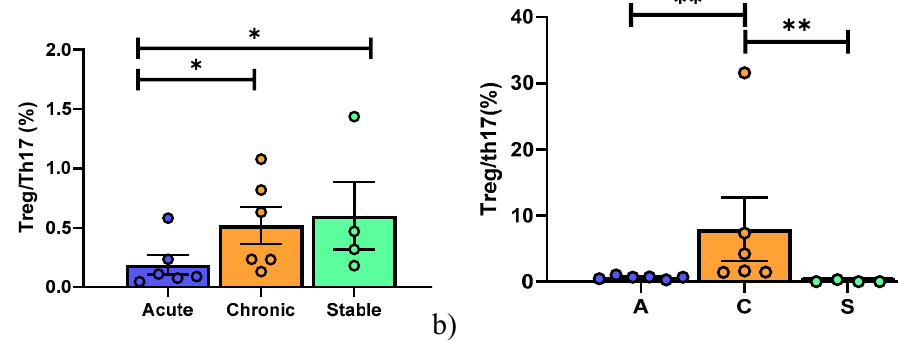
Figure 3. ( a ) Data represent individual values on PBMC, mean (center bar) ± SEM (upper and lower bars). If not indicated, p value is not significant. * p < 0.05, ** p < 0.01. ( b ) Data represent individual values on BAL samples, mean (center bar) ± SEM (upper and lower bars). If not indicated, p value is not significant. * p < 0.05, ** p < 0.01. Abbreviation: A: acute, C: chronic, S: stable.